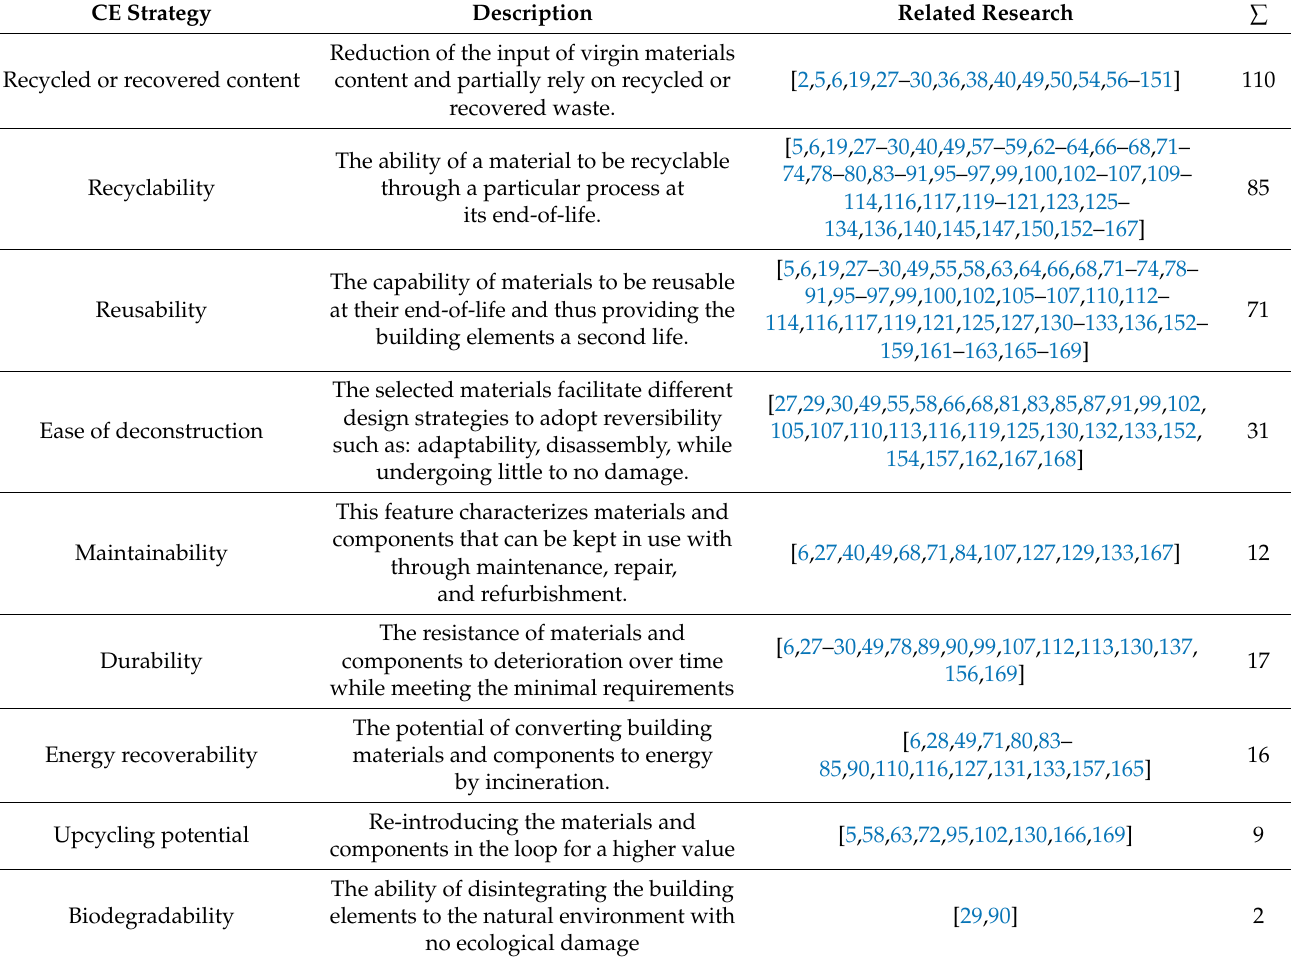
Table 2. Findings of materials and components criteria according to CE in the